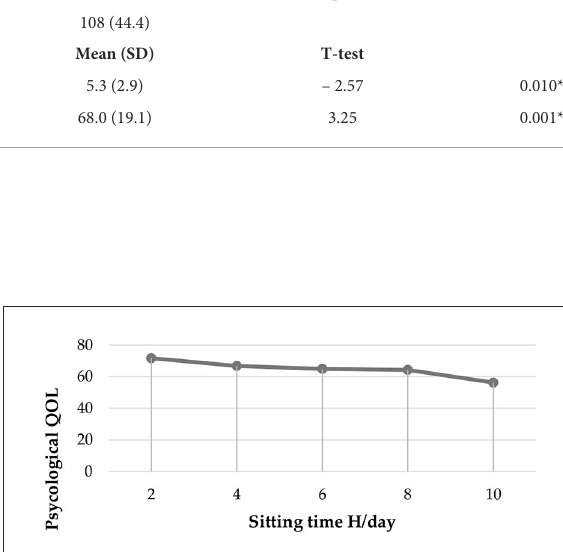
FIGURE1 Effect of sitting time per day on psychological QOL (compute means for continuous